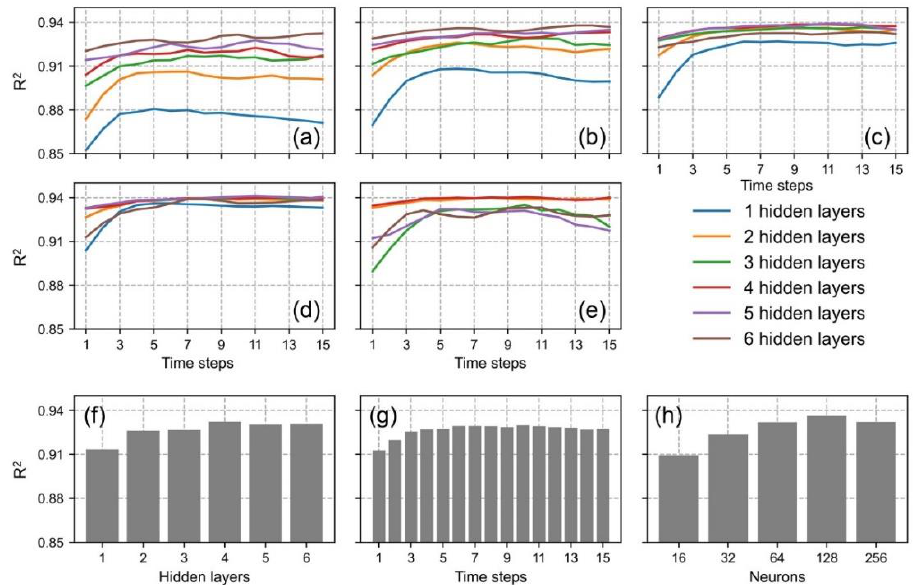
Figure 5. AR-LSTM model performance with different parameters. ( a – e ) are the R 2 curves of 16, 32, 64, 128, and 256 neurons with different layers and time steps, respectively. ( f – h ) are mean values of different hidden layers, time steps and different numbers of neurons, respectively.